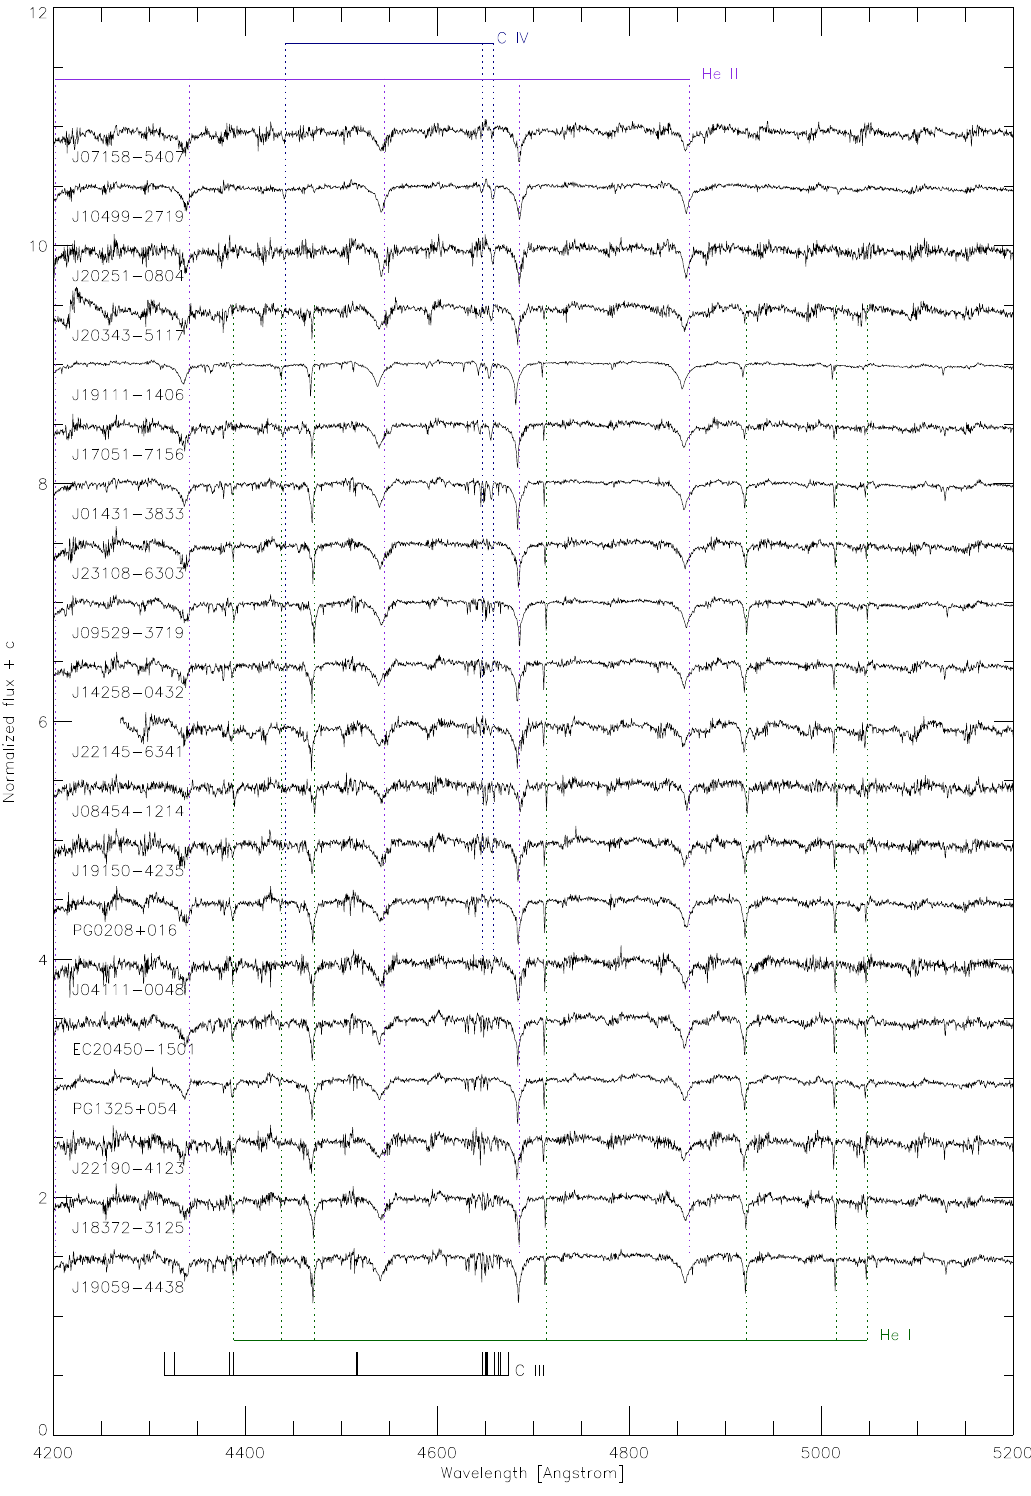
Figure 3. As Figure 2 continued. All stars in this panel are helium-rich and have been arranged approximately in order of increasing He ii /He i